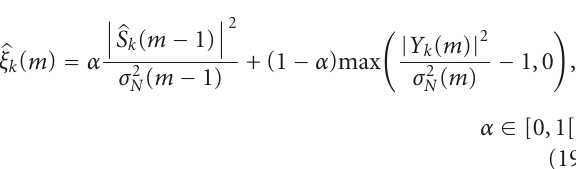
and an estimate which is built from the speech spectrum estimated in the preceding frame, (cid:12) S k ( m −